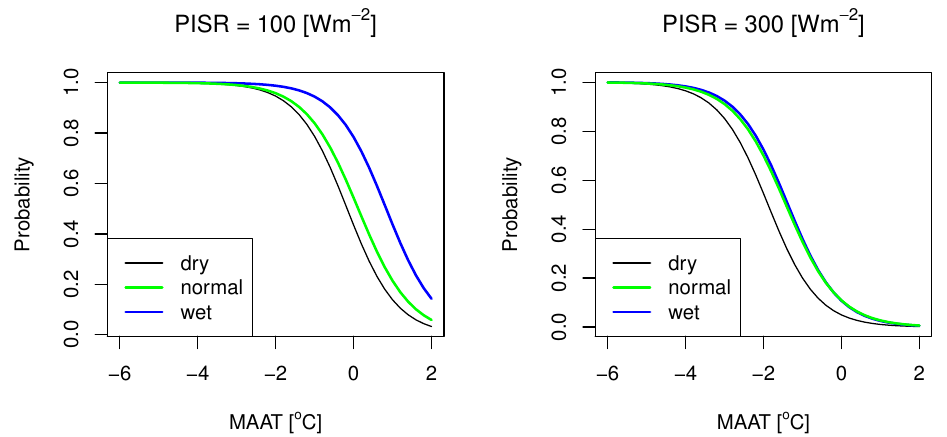
Fig. 6. Probabilities of a rock glacier being intact as opposed to relict for drier (mean PRECIP=1105mm), normal (mean PRE- CIP=1291mm) and relatively wet (mean PRECIP=1679mm) inventories using three different models (dry, mean, wet). The three models do not include cPRECIP as explanatory